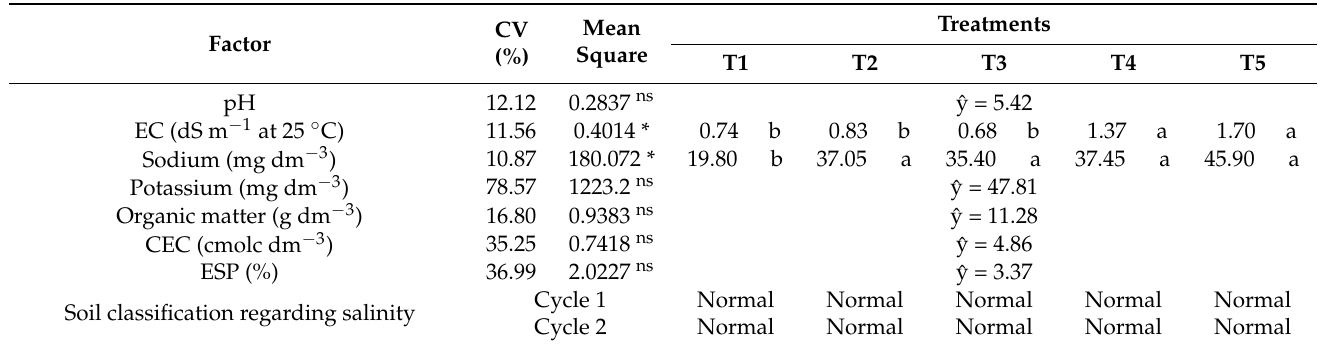
Table 2. Summary of the analysis of variance and mean values of soil chemical characteristics as a function of different water sources and